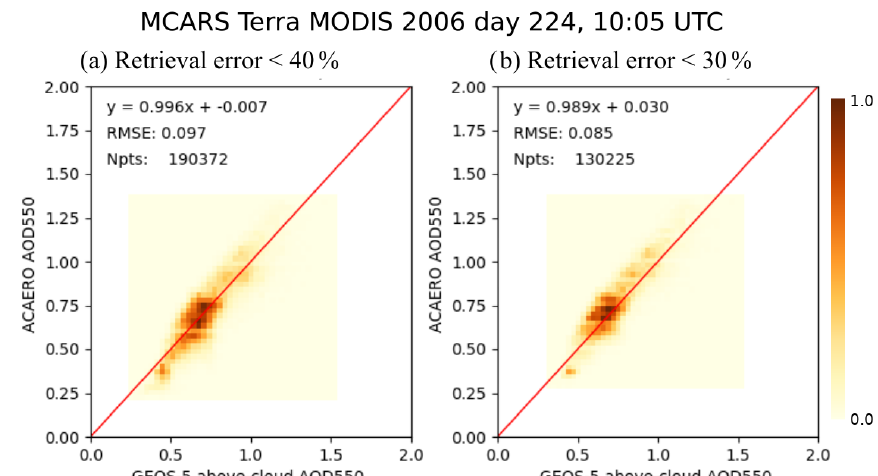
Figure 10. MOD06ACAERO retrieval results from simulated MCARS granule based on Terra MODIS 2006 day 224 10:05UTC compared to source GEOS-5 aerosol optical depth as a normalized density plot. In this experiment both MOD06 and MOD06ACAERO were modified to use MCARS pixel-level atmospheric profiles to perform atmospheric correction. AOD retrievals where COT was less than 4 and where the scattering angle was in the cloud bow are now discarded. Additionally the data extent had been limited to only include pixels with view zenith angle of less than 20 ◦ . This experiment shows excellent agreement with source data. Panel (a) shows MOD06ACAERO retrievals with uncertainty of less than 40%, and panel (b) shows the same with uncertainty less than 30%. The small dataset size in panel (b) is the reason for slightly lower agreement with source compared to panel (a)